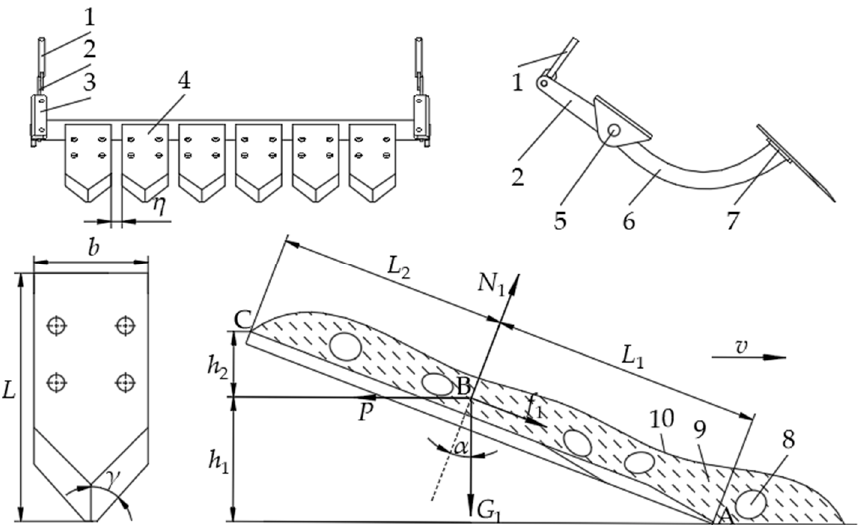
Figure 6. The digging components of the machine and the action of one shovel: 1—adjusting screw; 2—limiting lever; 3—hanger plate; 4—digging shovel; 5—digging-shovel shaft; 6—bending beam; 7—shovel holder; 8—potato; 9—soil; 10—plastic fi lm.